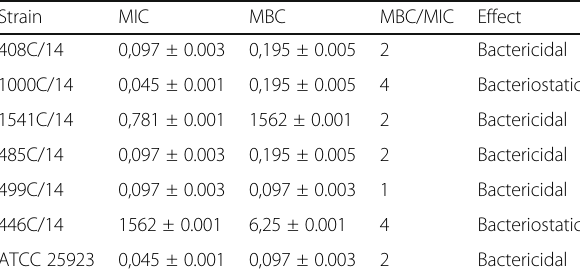
Table 3 Antibacterial activity of methanol extract of Tieghemella heckelii on Methicillin- resistant and reference strains of Staphylococcus aureus